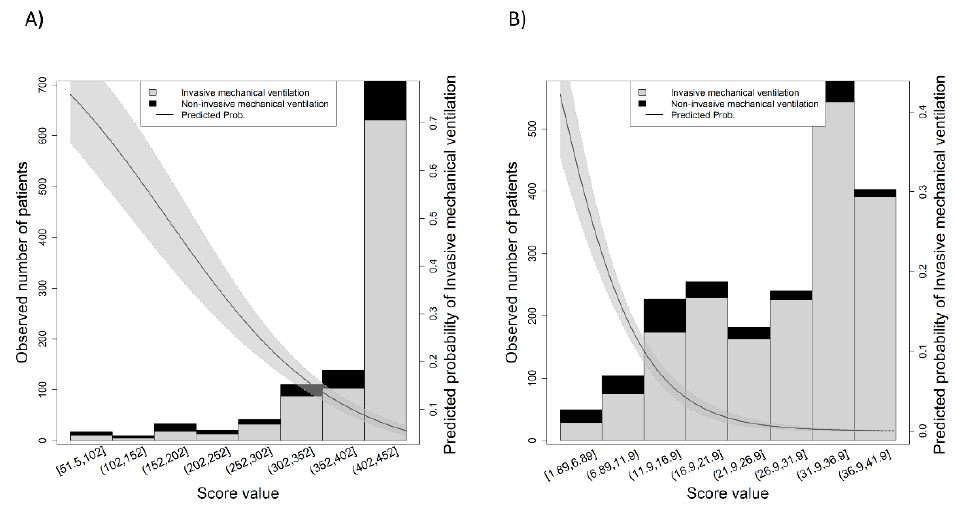
Figure 2. Observed number of cases for each of the scores: ( A ) SpO2/FiO2 ratio, ( B ) ROX index. The grey shadowed area shows the predicted probability of the outcome.